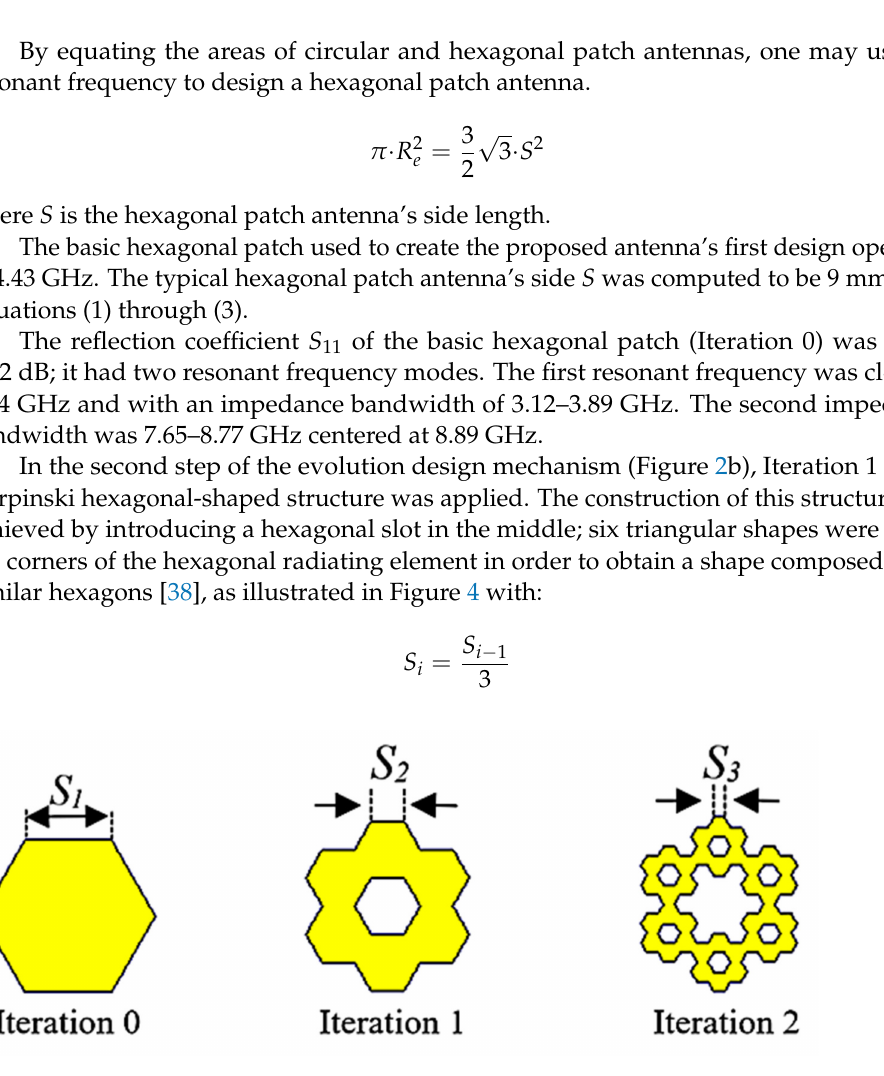
Figure 4. The structure of Sierpinski hexagonal-shaped fractal structure. Equation (5) indicates the Sierpinski hexagonal-shaped fractal’s Hausdorff